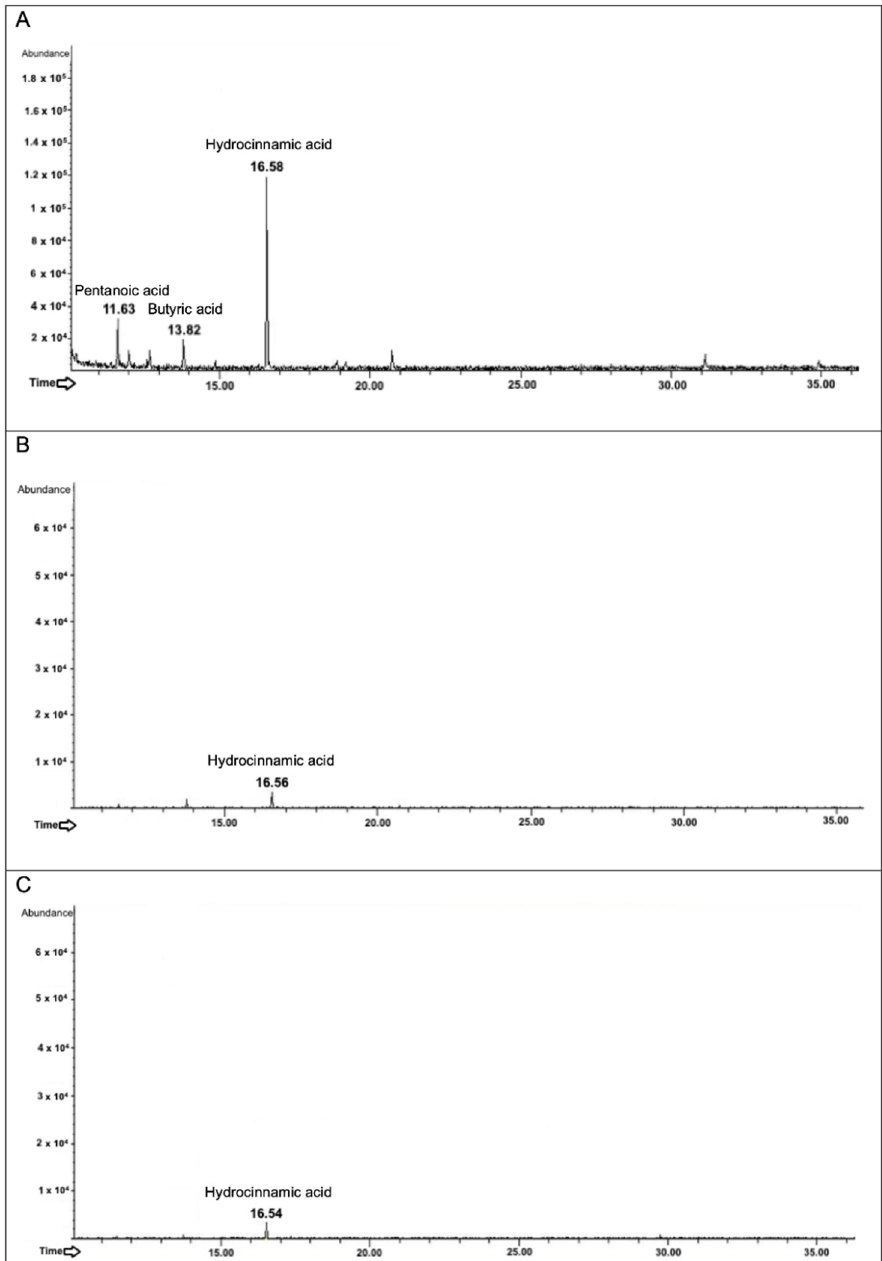
Figure 5. Secondary metabolites produced after the biotransformation of trans -cinnamic acid by L. plantarum , B. animalis subsp. lactis , and probiotic consortium. The figure shows the GC-MSD chromatograms. L. plantarum , B. animalis subsp. lactis , and the probiotic consortium were exposed for 48 h to trans -cinnamic acid at a final concentration of 1 mM. The identified intermediates are reported in ( A ) for L. plantarum , ( B ) for B. animalis subsp. lactis , and ( C ) for the probiotic